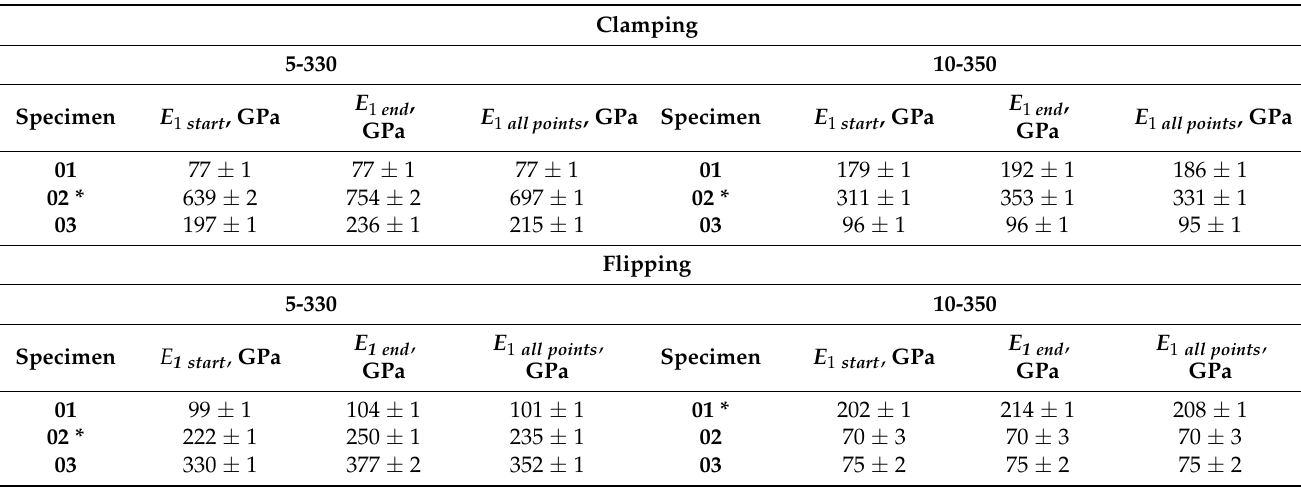
Table 3. E 1 calculated at the first and last 2.5 mm of the crack increment ( E 1 start and E 1 end ), and at the entire range of the crack length a calc ( E 1 all points ) for clamping- and flipping-laminates tested under fatigue mode I loading.